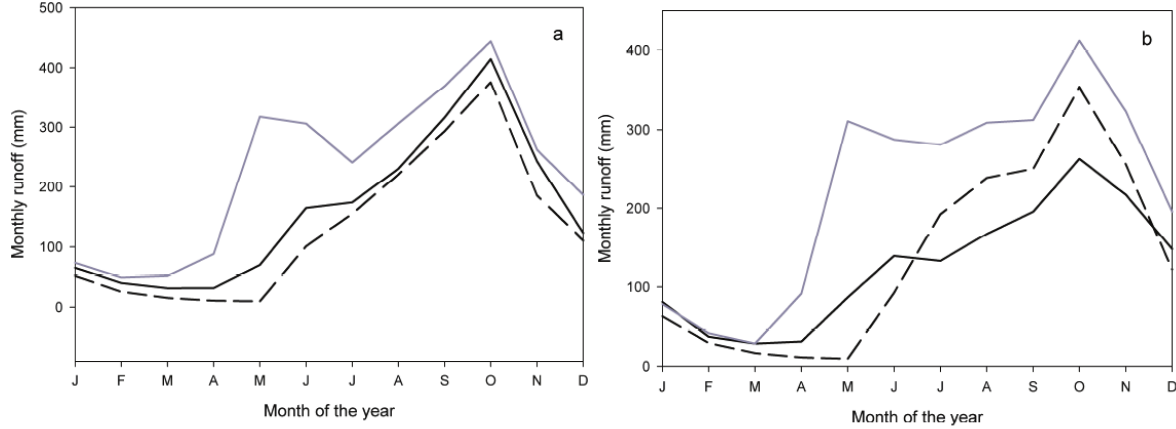
Fig. 7. Two examples of contrasting seasonal catchment behaviour, according to the water storage term from Eq. (14): (a) a catchment without significant storage term (San Juan, Panama), and (b) a catchment (Los Ca˜nones, Panama) with recharge during the rainy season (July to November) and discharge later on. Rainfall (gray straight line), observed (black straight line) and modelled (black dashed line) monthly runoff.